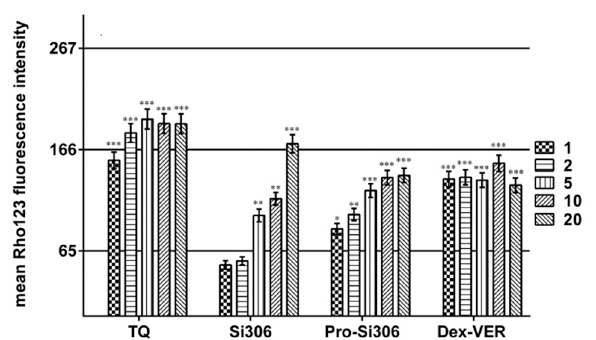
Figure 3. Dose-dependent inhibition of P-gp function. Rho 123 accumulation in U87-TxR cells (values expressed as mean fluorescence intensity ± S.D.) was assessed after application of different concentrations of Si306, pro-Si306, Dex-VER (1, 2, 5, 10, 20 µM) and TQ (1, 2, 5, 10, 20 nM). The mean